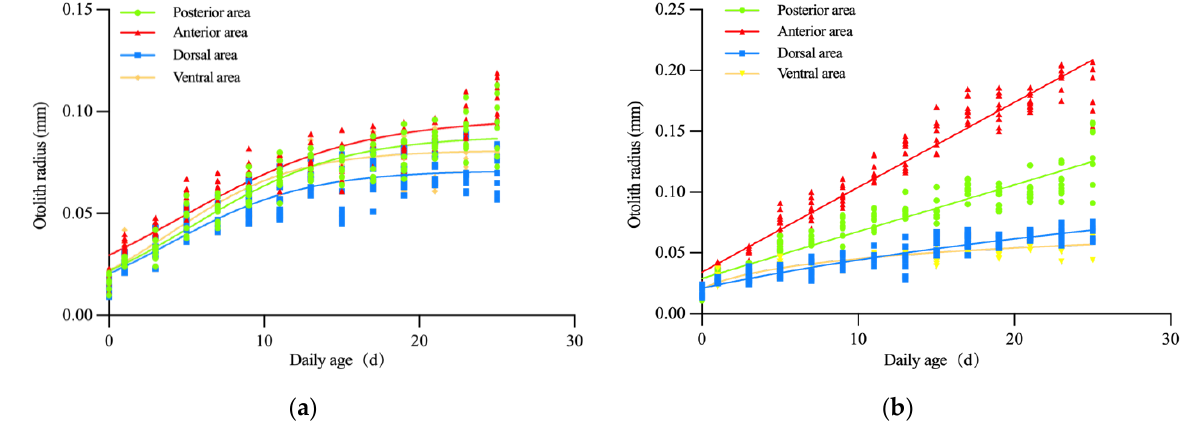
Figure 4. The relationship between daily age and otolith radius of lapilli ( a ) and sagittae ( b ) of Sinogastromyzon wui : ( a ) posterior area, OR t = ‐ 0.045 + 0.04 × ln(t + 4.563) ( R 2 = 0.9086) ; anterior area, OR t = ‐ 0.013 + 0.033 × ln(t + 2.72) ( R 2 = 0.9090) ; dorsal area, OR t = ‐ 0.001 + 0.022 × ln(t + 1.806) ( R 2 = 0.8370) ; and ventral area, OR t = ‐ 0.0025 + 0.025 × ln(t + 1.631)( R 2 = 0.8299) ; ( b ) posterior area, OR t = 0.004 t + 0.029 ( R 2 = 0.8838) ; anterior area, OR t = 0.0074 t +0.034 ( R 2 = 0.9449) ; dorsal area, OR t = 0.022 𝑒 ( ‐ 0.021x) ( R 2 = 0.8479); and ventral area OR t = 0.023 𝑒 ( ‐ 0.124x) ( R 2 = 0.8223).